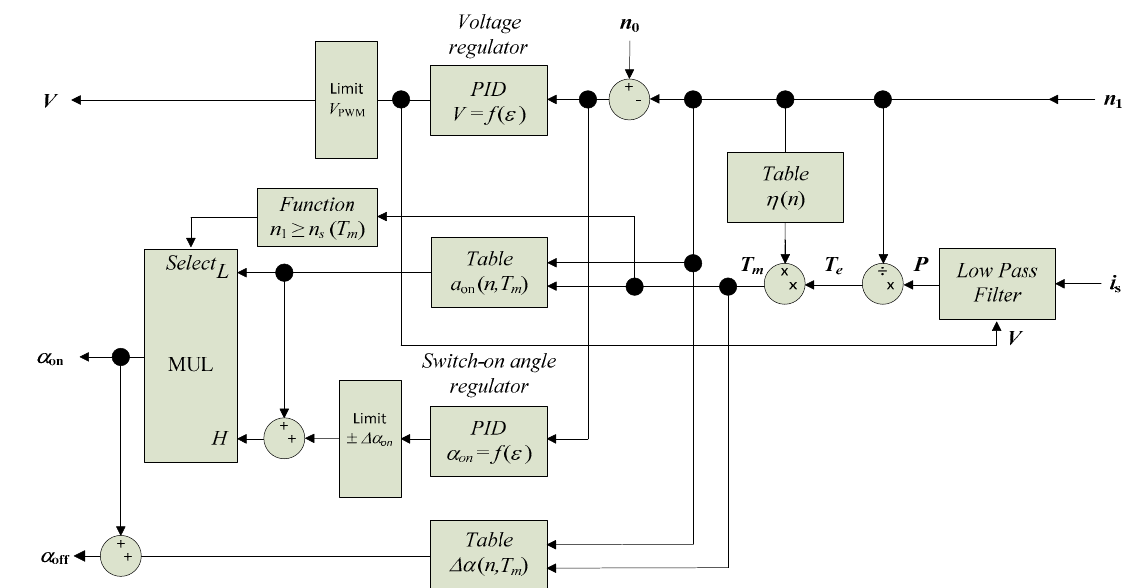
Figure 6. Structure of the proposed regulator for SRM drive.